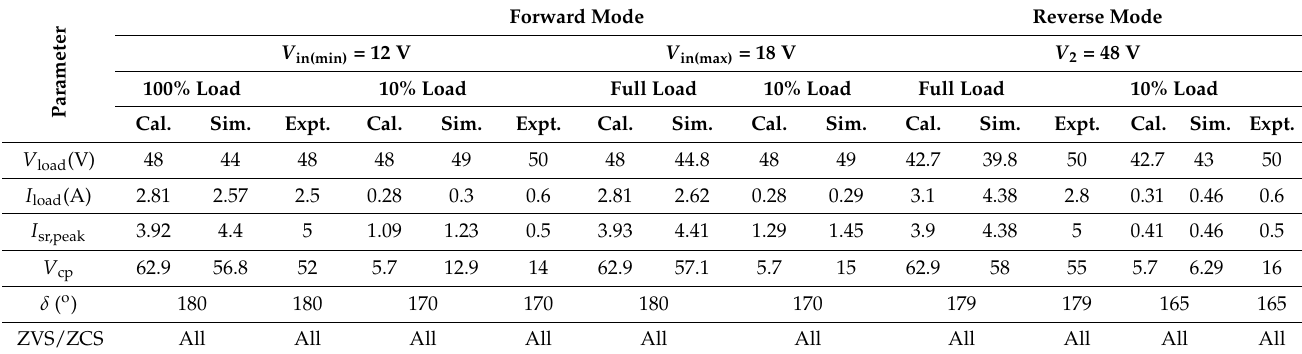
Table 3. Comparison of theoretical and simulation values in forward mode with an input voltage V in = 12V (min) & 18 V (max). and reverse mode with an input voltage V 2 or V o = 48 V.